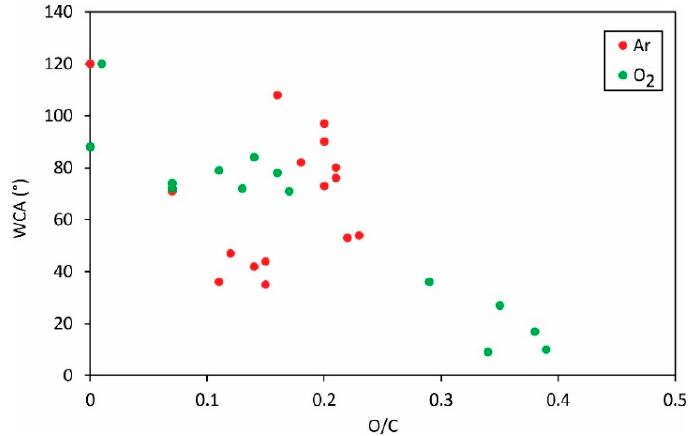
Figure 5. The static water contact angle versus the O/C ratio in the surface film as probed by XPS. Again, the results are scattered, but the trend is obvious: a larger concentration of oxygen in the surface film results in a lower static water contact angle. The large oxygen concentration is therefore favorable for high surface wettability, the same as for most other polymers. The significant deviation of the measured points for argon plasma from the general trend is, again, explained by different mechanisms as illustrated in Figures 1–3. The static WCA versus the ratio between fluorine and carbon concentrations is plotted in Figure 6. Despite the large scattering of the reported results, the general observation is that the WCA increases with increasing F/C. Therefore, the defluorination is beneficial for increased wettability of this hydrophobic polymer.